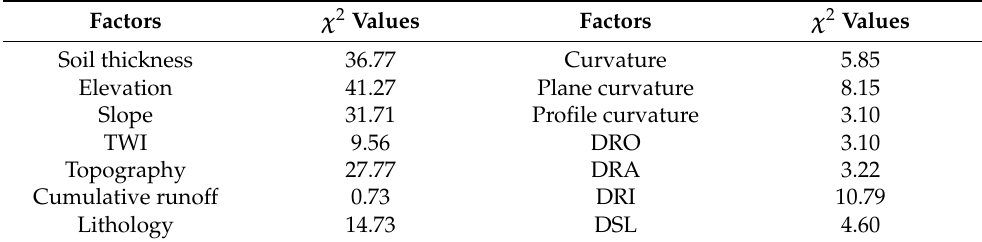
Table 1. χ 2 values of the 14 Table 1. 𝜒 2 values of the 14 factors.